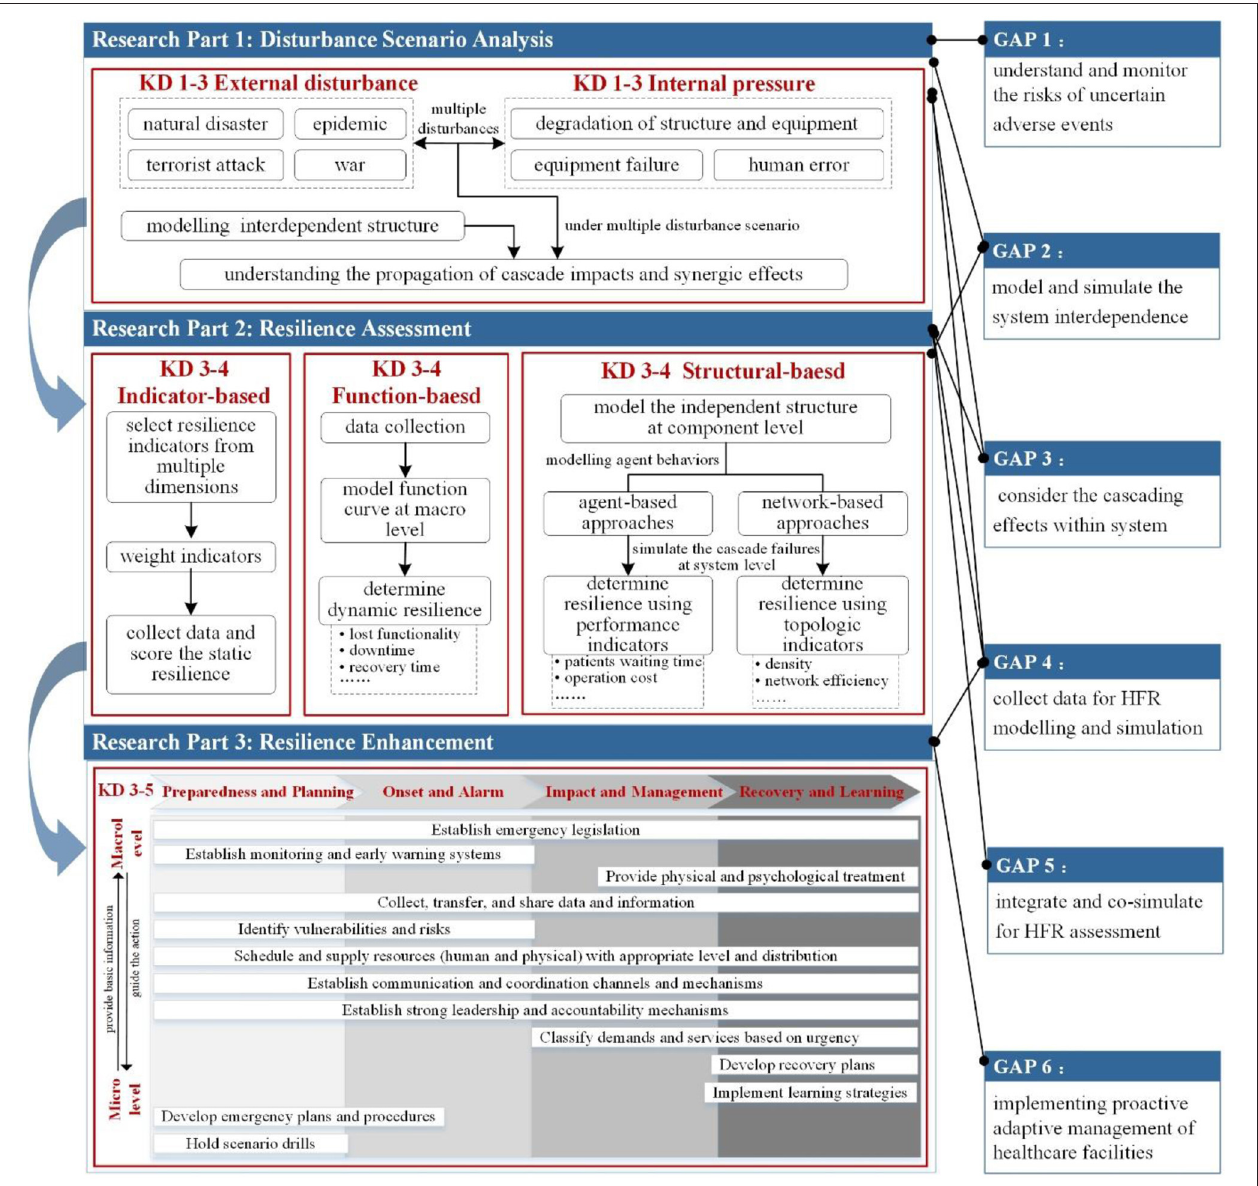
FIGURE 8 | Knowledge map of